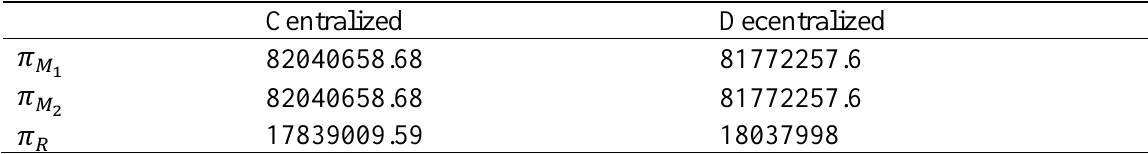
Table 3. Different profits under different